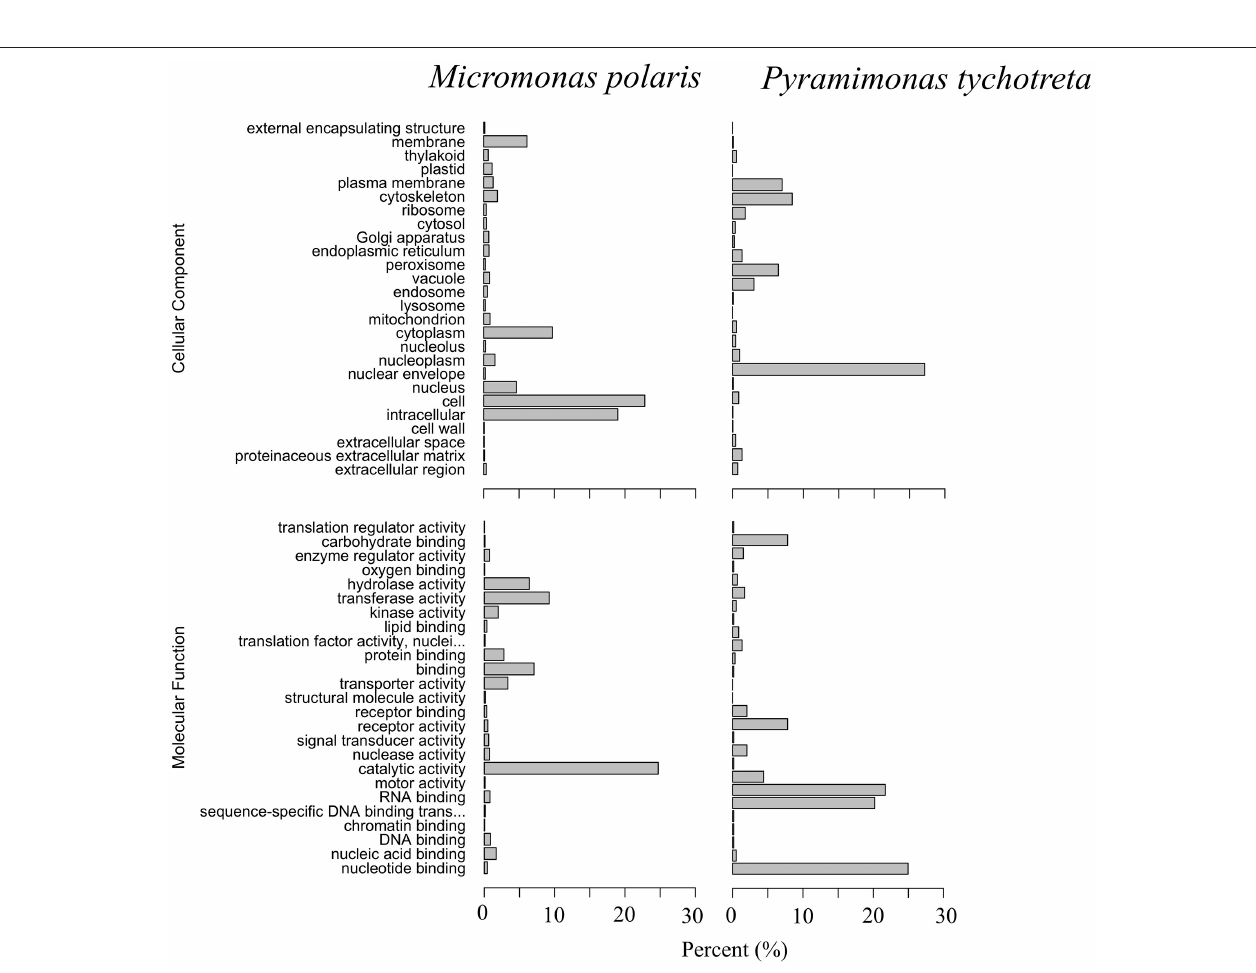
FIGURE 2 | Gene Ontology (GO) summaries of M. polaris and P. tychotreta transcriptomes as a percentage of total identified transcripts. GO terms were grouped by Molecular Function and Cellular Component.